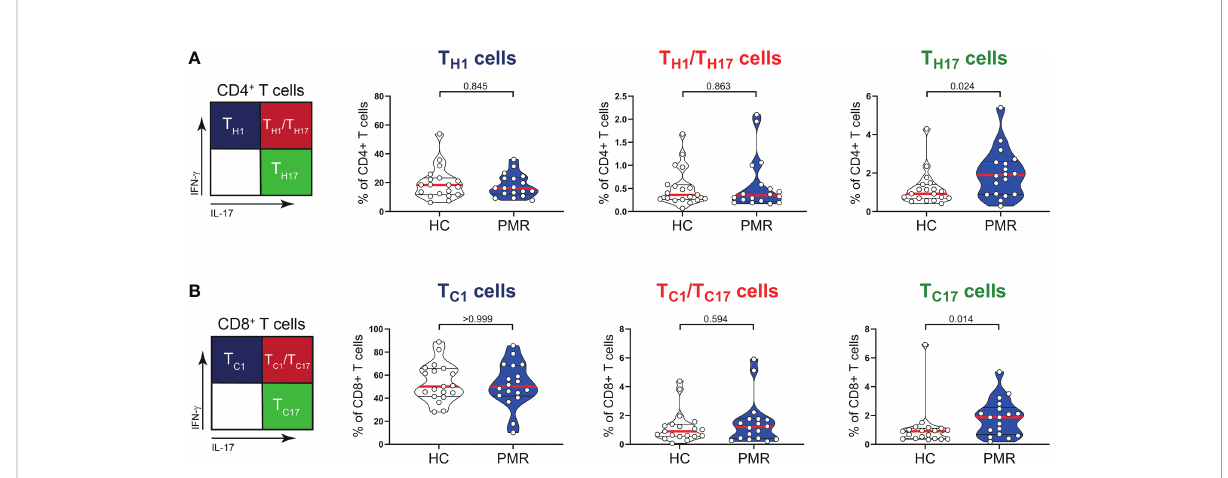
FIGURE 2 IFN- g and IL-17 production by T cells in peripheral blood of patients with PMR. (A) Schematic overview (left panel) and percentages (right panel) of CD4 + IFN- g + IL-17 - (T H1 ), CD4 + IFN- g + IL-17 + (T H1 /T H17 ) and CD4 + IFN- g - IL-17 + (T H17 ) T cells, and (B) CD8 + IFN- g + IL-17 - (T C1 ), CD8 + IFN- g + IL-17 + (T C1 /T C17 ) and CD8 + IFN- g - IL-17 + (T C17 ) T cells in peripheral blood of 18 patients with PMR and 19 healthy controls (HC). Statistical signi fi cance by Mann-Whitney U test is indicated.